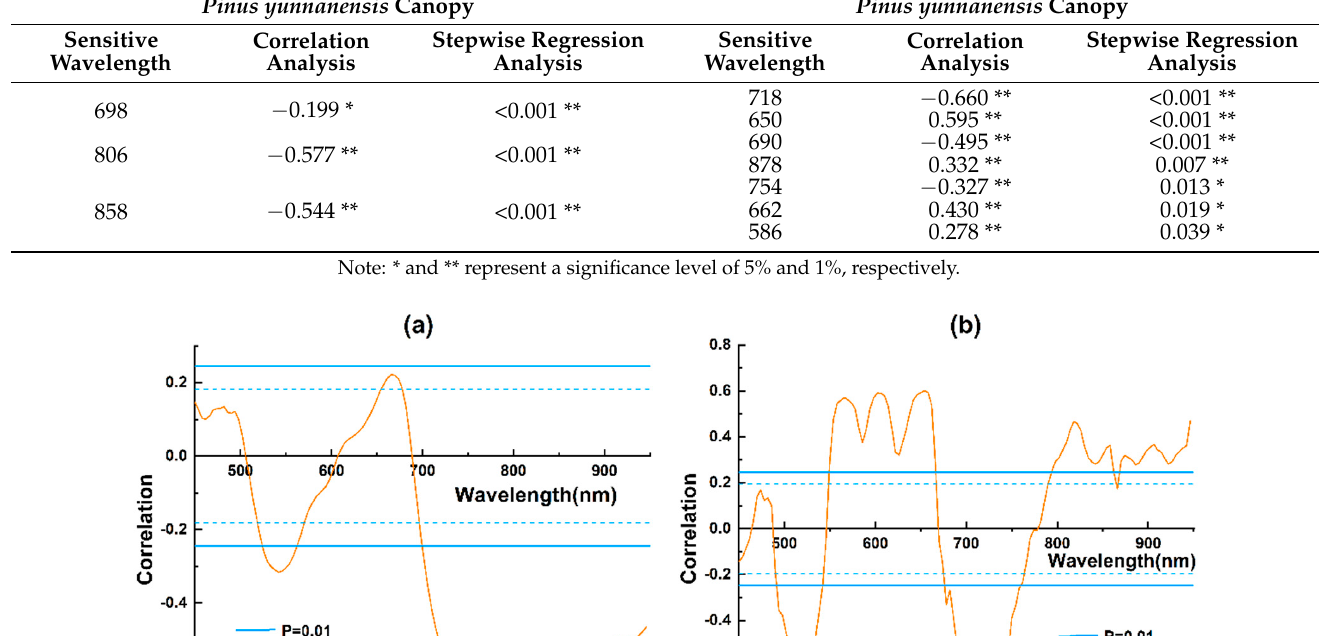
Table A1. Extraction of sensitive bands for spectral reflectance and the first derivative of Pinus yunnanensis canopy. Figure S2. The first derivative curves of different damage degree Pinus yunnanensis canopy by Tomi- cus. ( a ). the first derivative curves of the canopy spectra; ( b ). the first derivative average curves of the canopy spectra.